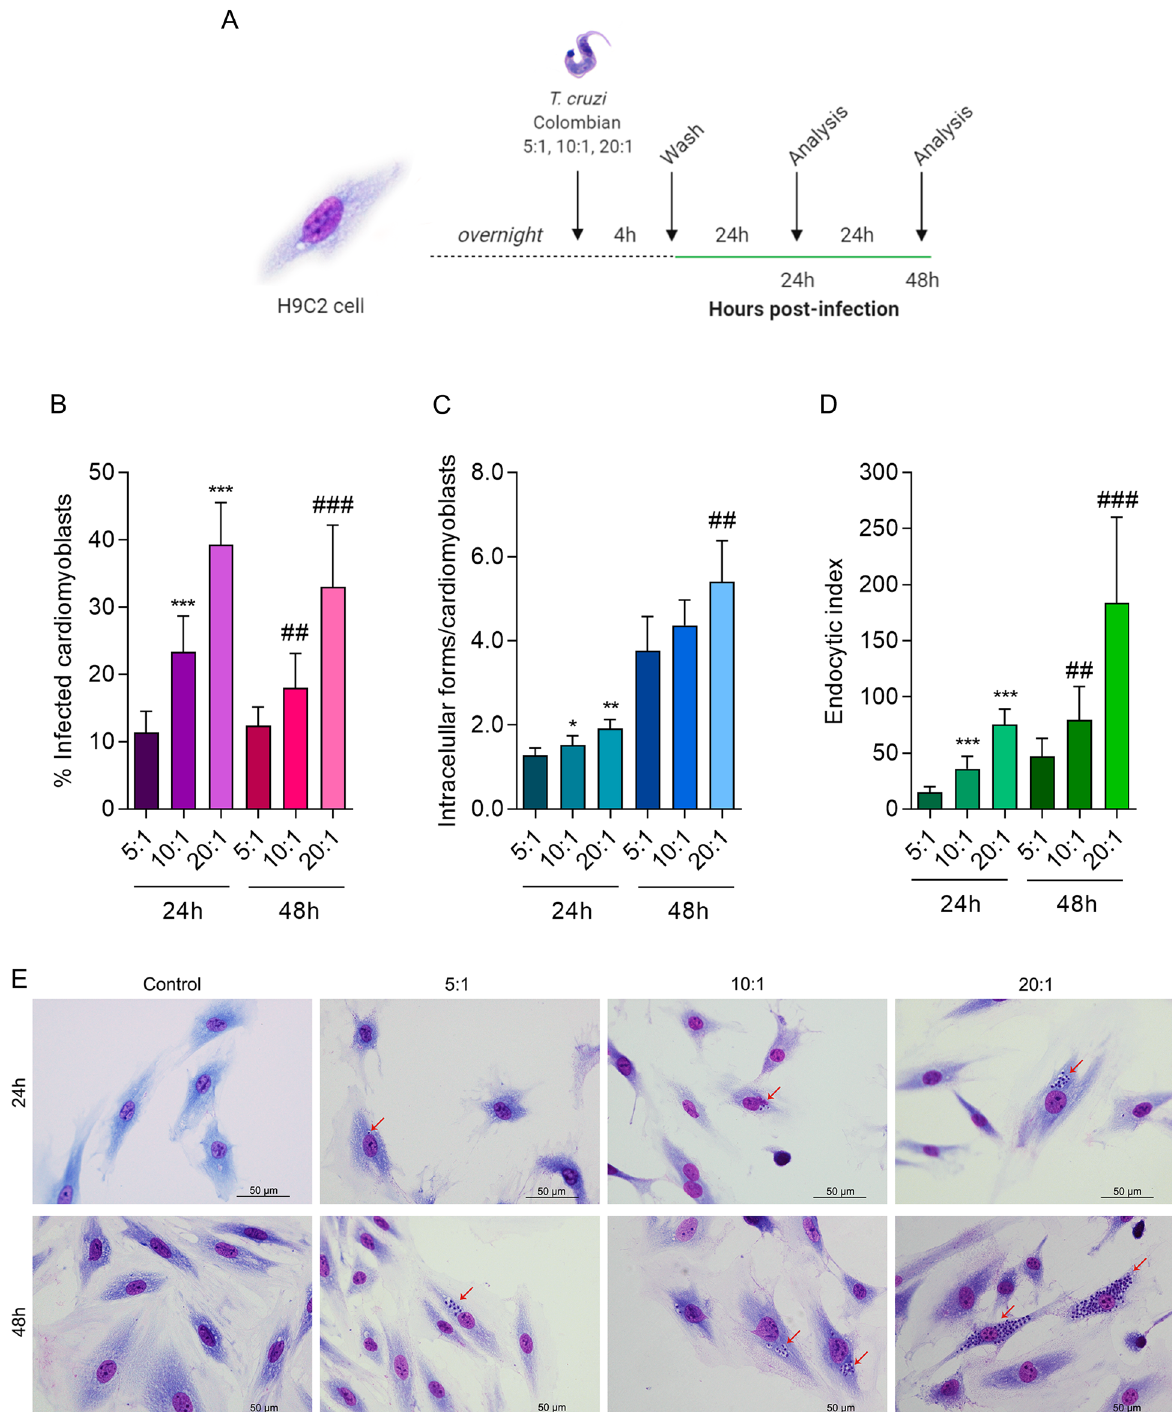
Figure 1. Standardization of T. cruzi infection in H9C2 cells. ( A ) H9C2 cells were infected with 5:1, 10:1 and 20:1 T. cruzi trypomastigotes for 4 h, washed and collected 24 h and 48 h post-infection. ( B ) Percentage of infected cardiomyoblasts. ( C ) Rate of intracellular forms/cardiomyoblasts. ( D ) Endocytic index. ( E ) Microscopic images of H9C2 cells infected with T. cruzi Colombian strain stained with panoptic. Red arrows indicate intracellular forms of T. cruzi . For all graphs, significance was determined using unpaired Student’s t test: 10:1/24 h, 20:1/24 h vs. 5:1/24 h (*p < 0.05, **p < 0.01, ***p < 0.001); 10:1/48 h, 20:1/484 h vs. 5:1/48 h ( # p < 0.05, ## p < 0.01, ### p < 0.001). The experiment was repeated three times, using different cell culture flasks in each experimental